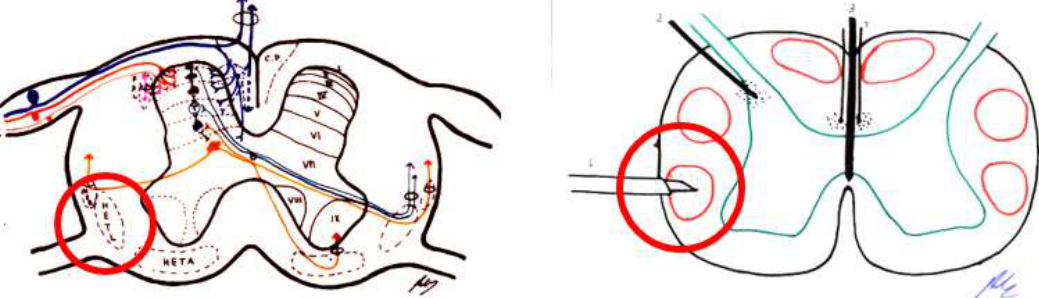
Figure 8. Lesion zone in the spinothalamic tract (see text). C.P. = P.C. (Posterior cord). HER = SRT (Spinoreticular tract). HETL = LSTT (Lateral spinothalamic tract). HETA = VSTT (Ventral spinothalamic tract). FDL = DLF (Dorsolateral fasciculus, Lissauer’s tract).